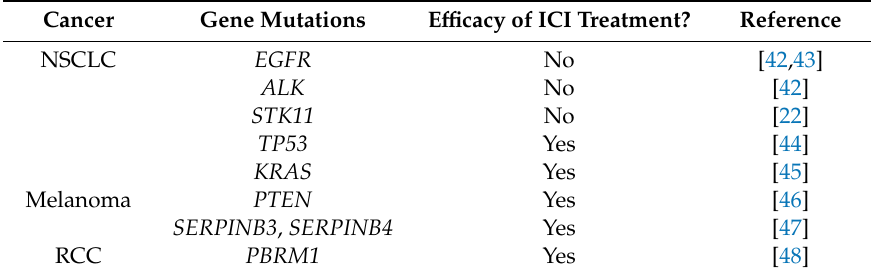
Table 3. Specific gene mutations and the e ffi cacy of ICI